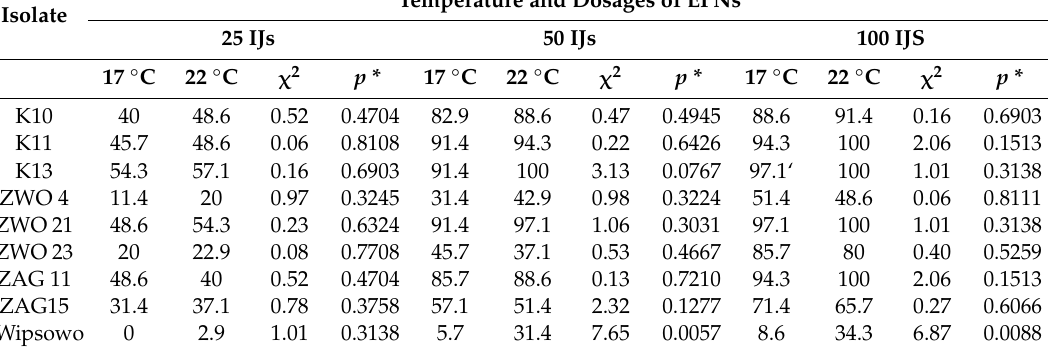
Table 3. The e ff ect of temperature on the mortality of the cabbage moth parasitism (%) by EPNs applied at three dosages.